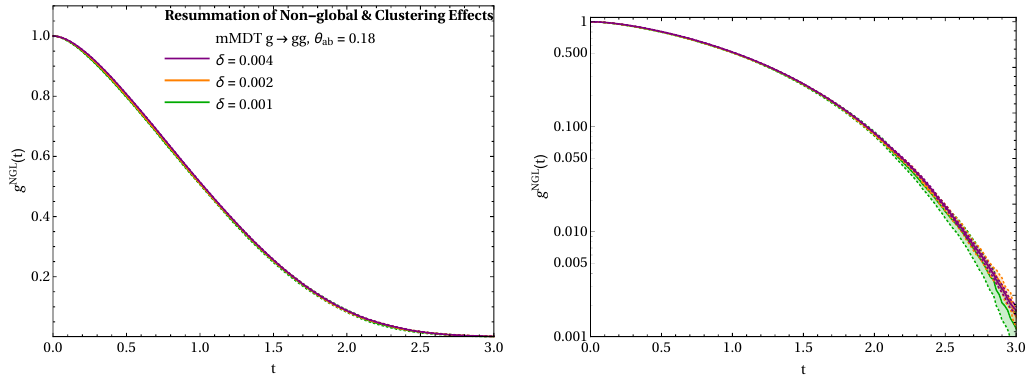
Figure 7 . The cuto(cid:11) dependence and statistical uncertainties for the MC determination of the NGL spectrum. Shown are gluon initiated jets with angular cuto(cid:11)s (cid:14) = 0 : 001 ; 0 : 002 and 0 : 004. The bands (present in both plots) represent the statistical uncertainty, and the spectra are shown for both linear and logarithmic